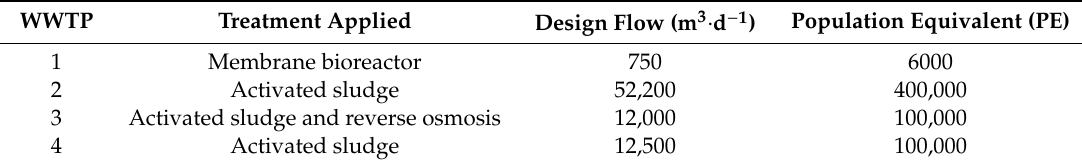
Table 2. General characteristics of the selected conventional wastewater treatment plants